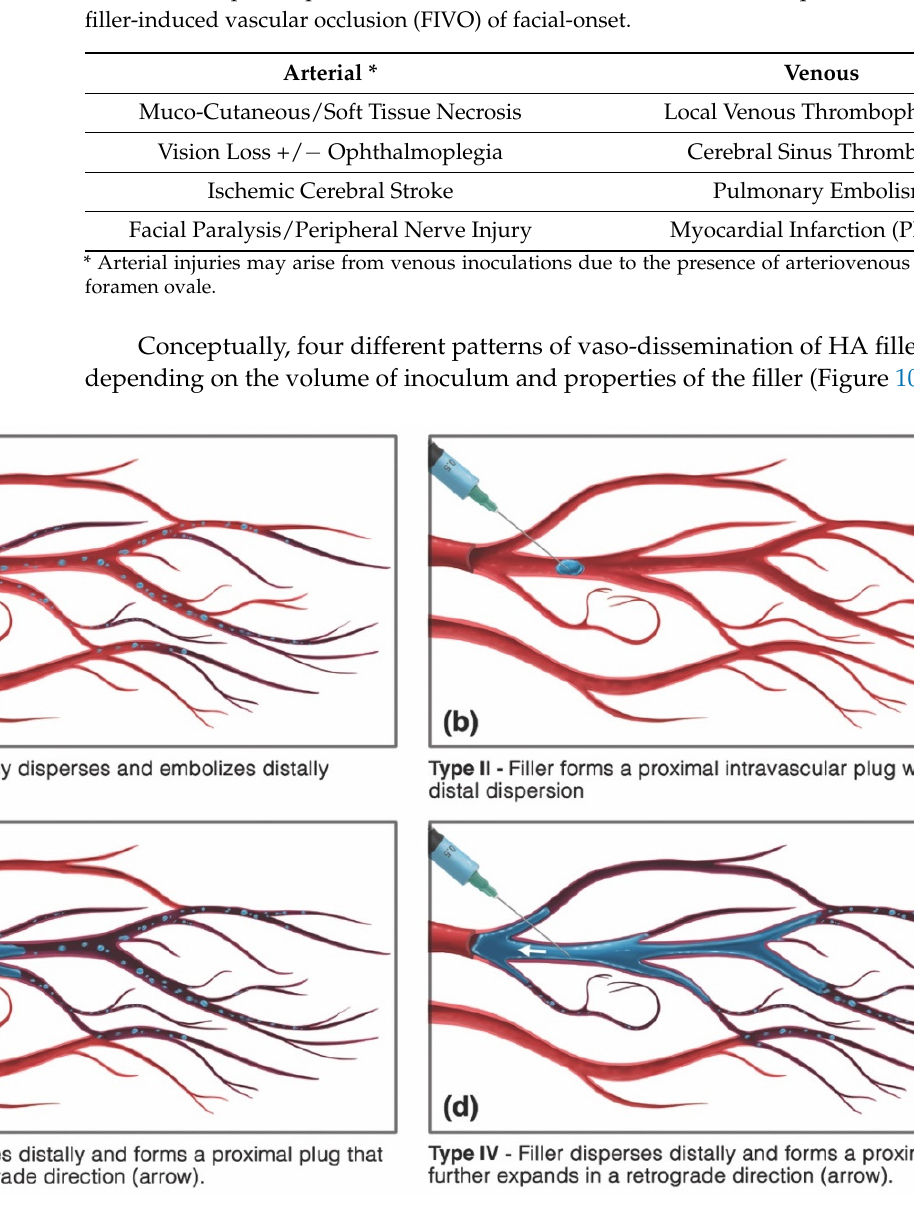
Figure 10. Possible vaso-dissemination mechanisms of intravascular hyaluronan gels. ( a ) Type I, filler completely disperses and embolizes distally, clearing the main lumen. ( b ) Type II, filler does not disperse and instead forms a proximally occlusive intraluminal plug. ( c ) Type III, filler disperses distally and forms a proximal intravascular plug that expands in an anterograde direction. ( d ) Type IV, filler disperses distally and forms a proximal intravascular plug that further expands in a retrograde direction, causing the additional occlusion of upstream